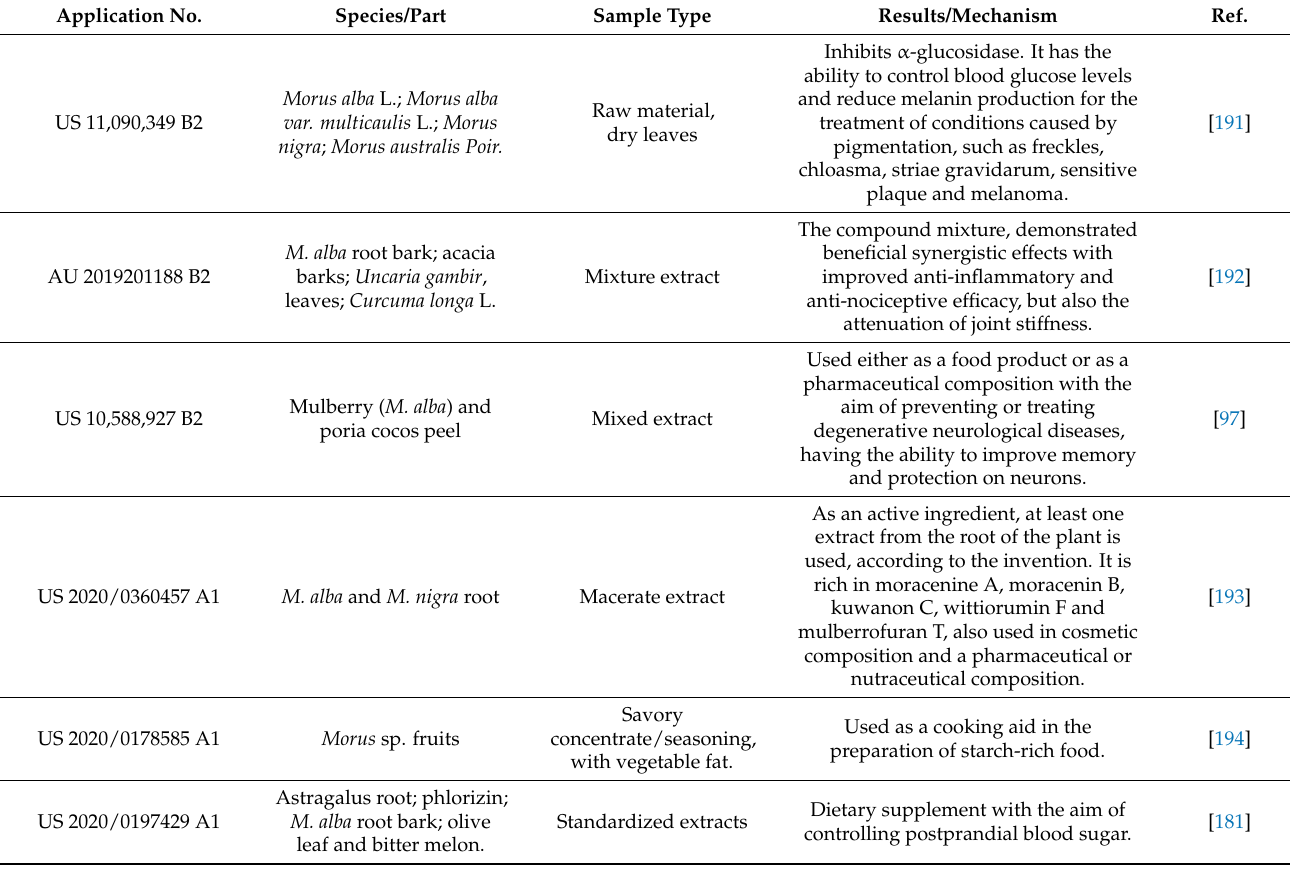
Table 6. List of patents based on the therapeutic and functional applications of Morus